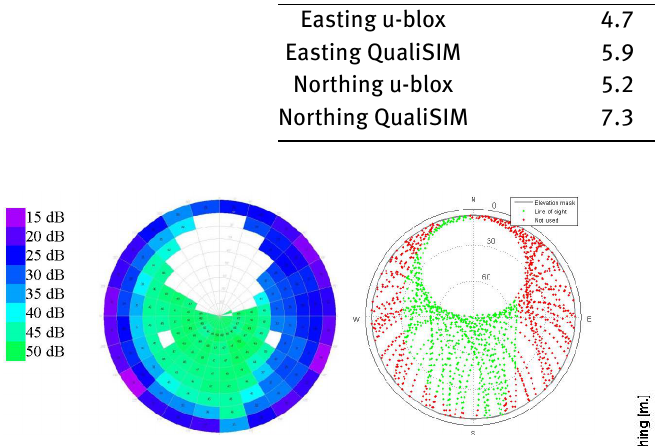
Table 3: Standard deviation and mean values for the positions from the u-blox receiver and for positions estimated by QualiSIM Standard deviation [m.]